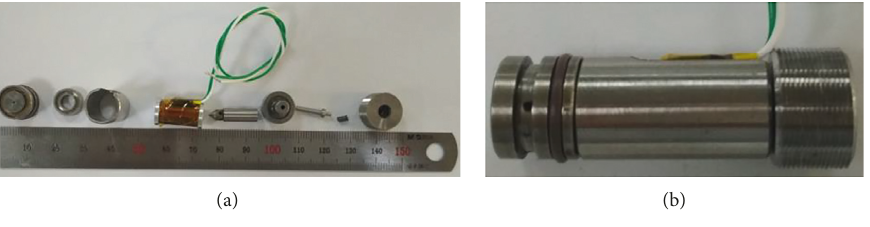
Figure 6: Micro high-speed digital